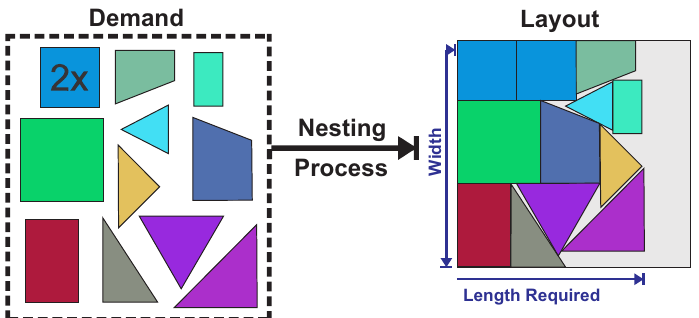
Figure 1. Example of a two-dimensional C&P problem with irregular items and a single open- dimensional surface of fixed width and variable length. This is a 2 | Si | Oo problem according to Araújo et al.’s taxonomy